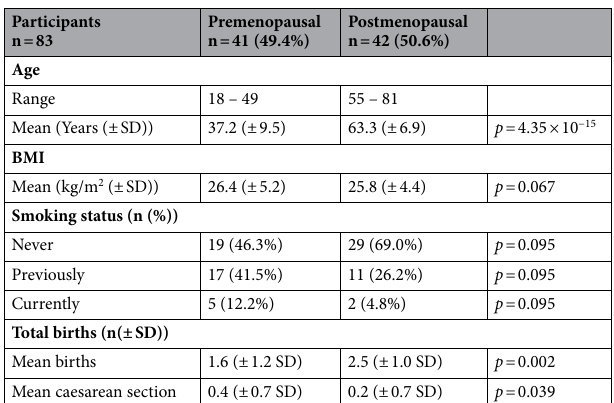
Table 1. Demographic characterization of study